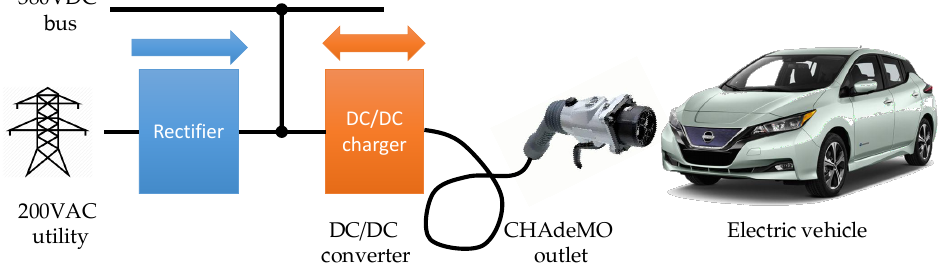
Figure 1. Three-phase dual active bridge converter